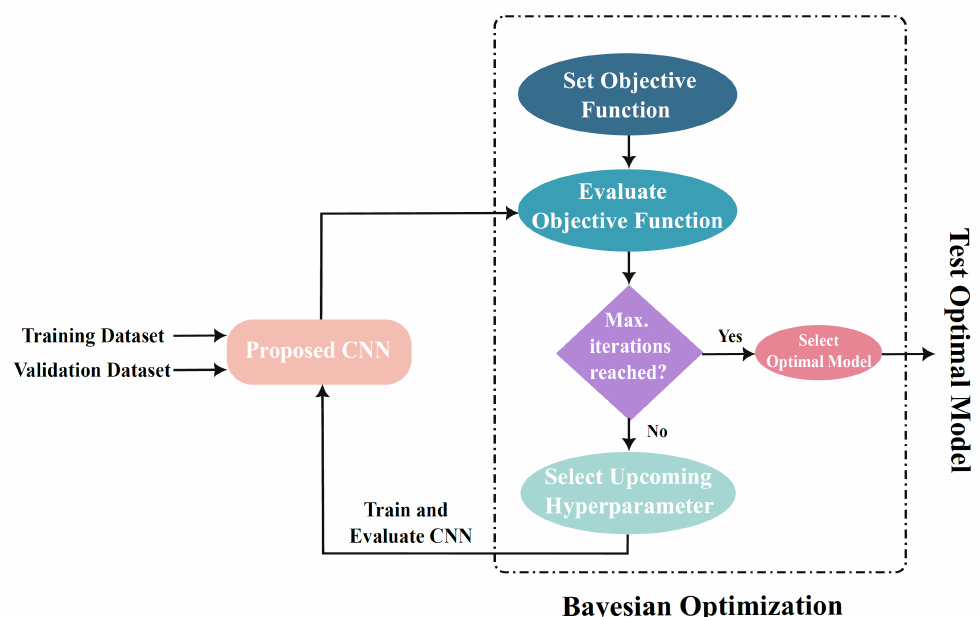
Figure 4. The Bayesian optimization framework for DLN hyperparameter